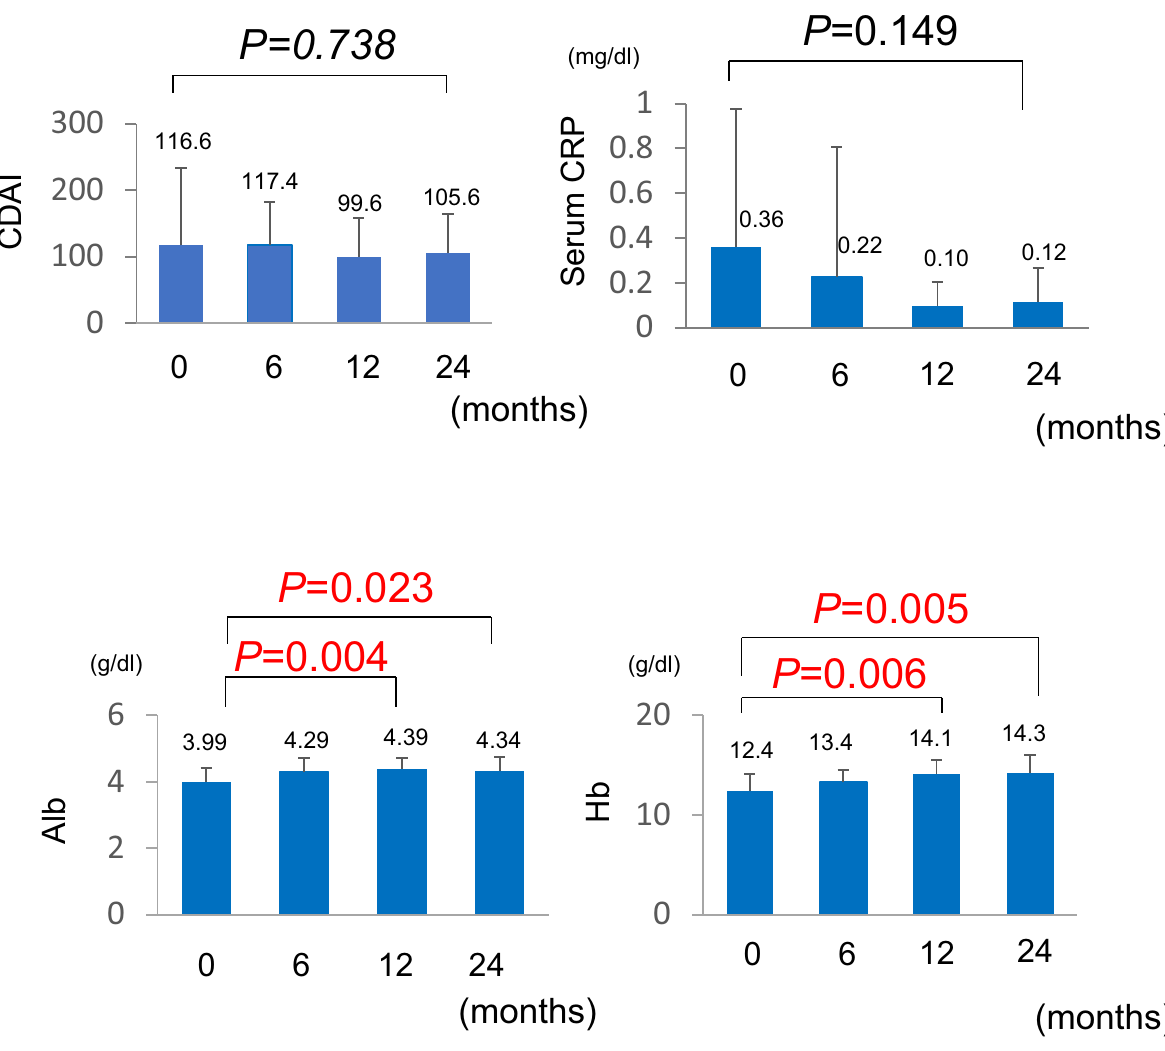
Figure 4. Two-year changes in CDAI and levels of CRP, Alb, and Hb in the continuous treatment group with good compliance after changing to mesalazine granules. CDAI Crohn’s Disease Activity Index, CRP C-reactive protein, Alb albumin, Hb